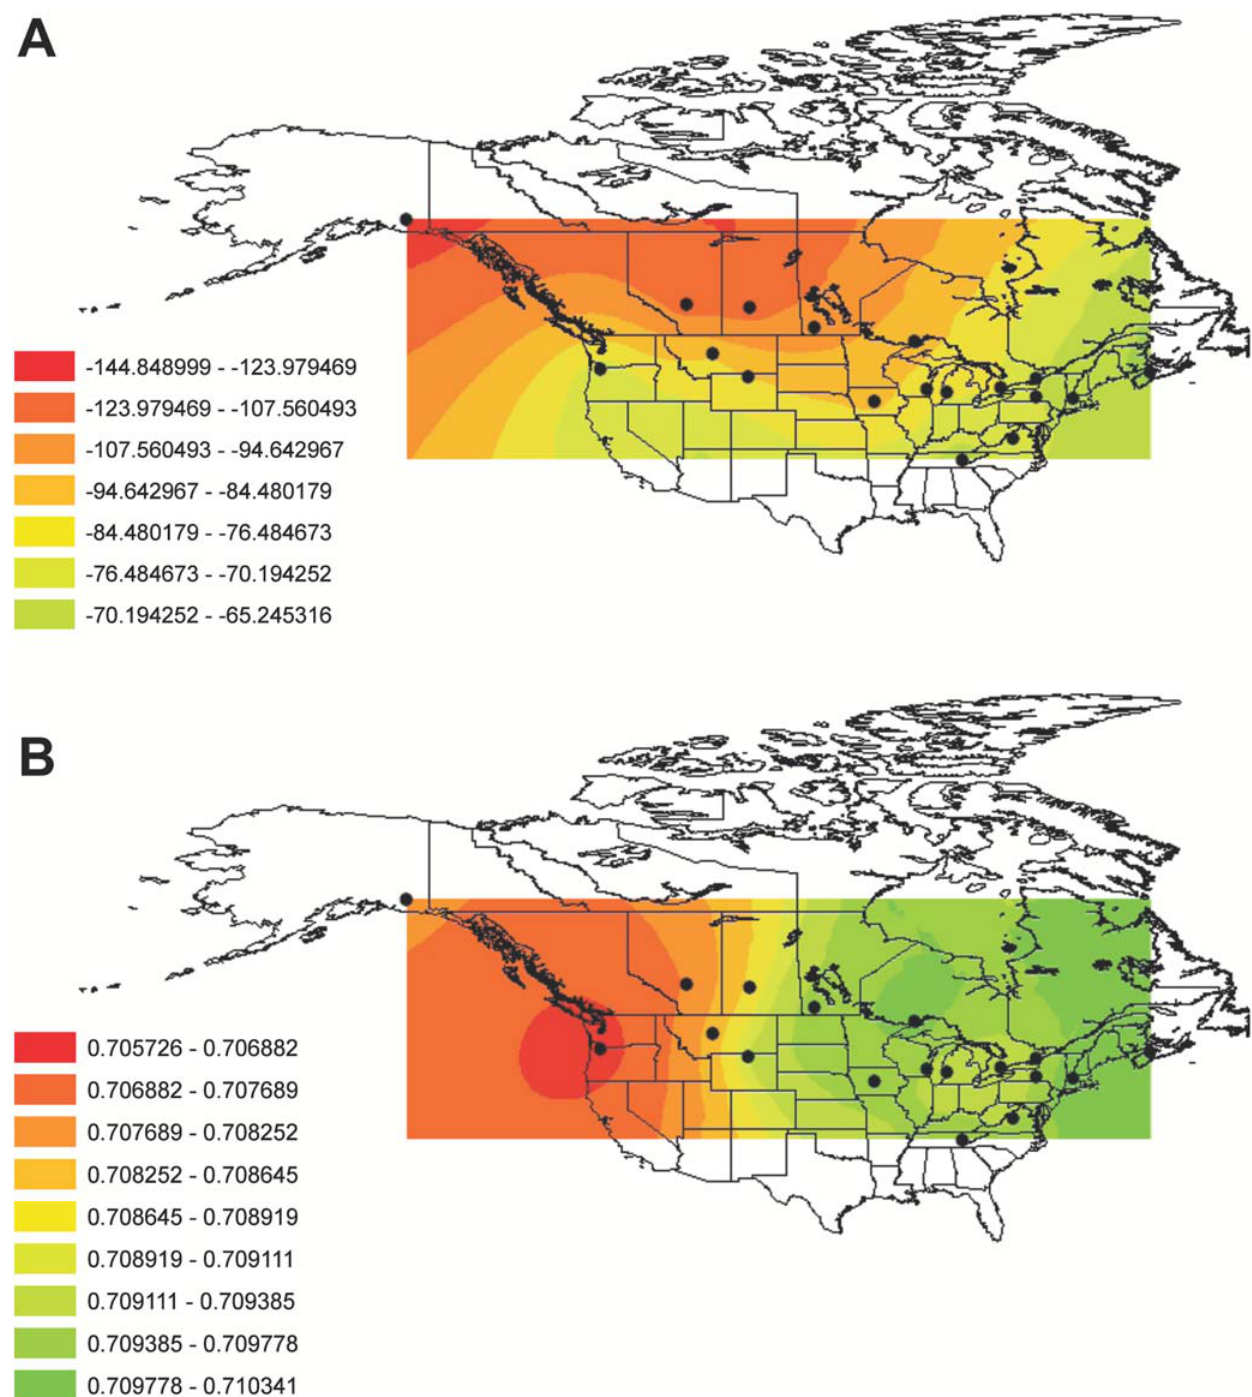
Figure 4. Geographic variation of (a) d D and (b) 87 Sr/ 86 Sr values in Tree Swallow feathers. Contour maps were produced by ordinary kriging and are based on mean values in primary flight feathers at 18 breeding sites (denoted by black circles).